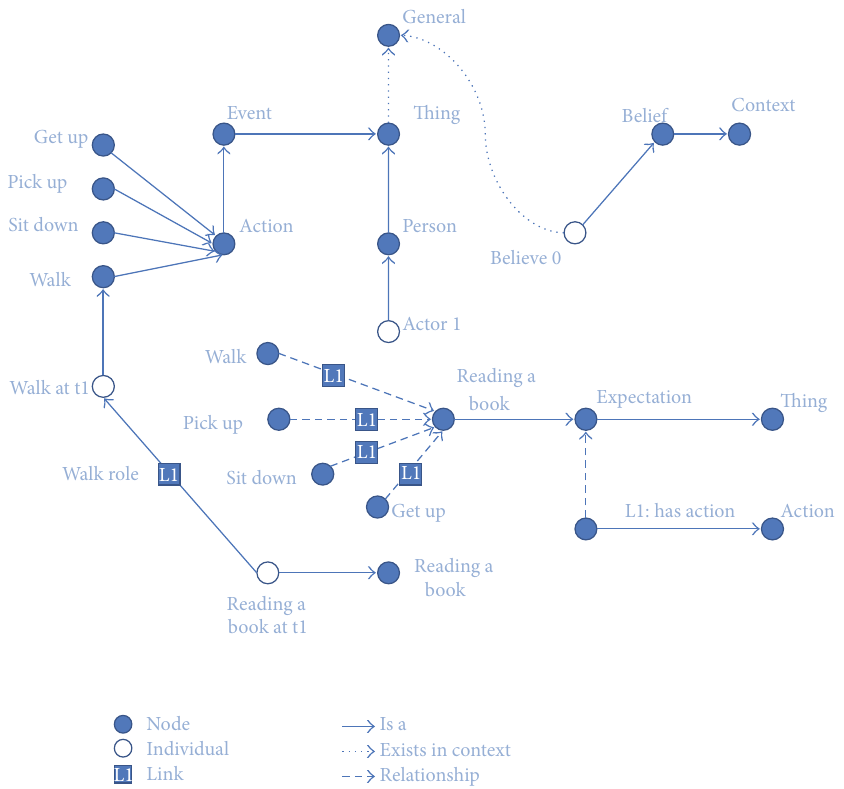
Figure 3: Knowledge modeled using